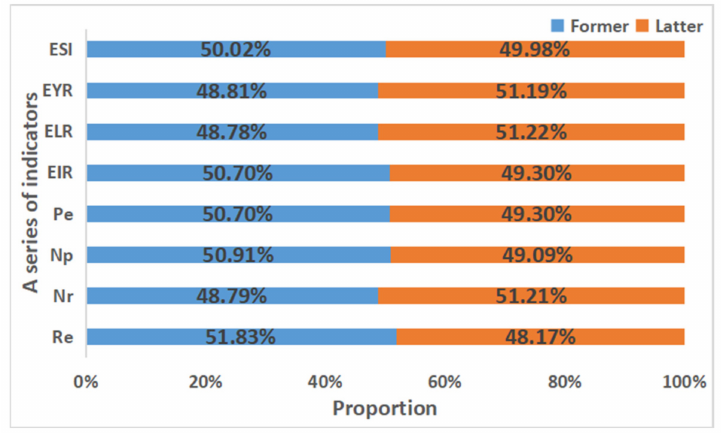
Figure 13. Comparison of former and latter based on 5% increment.